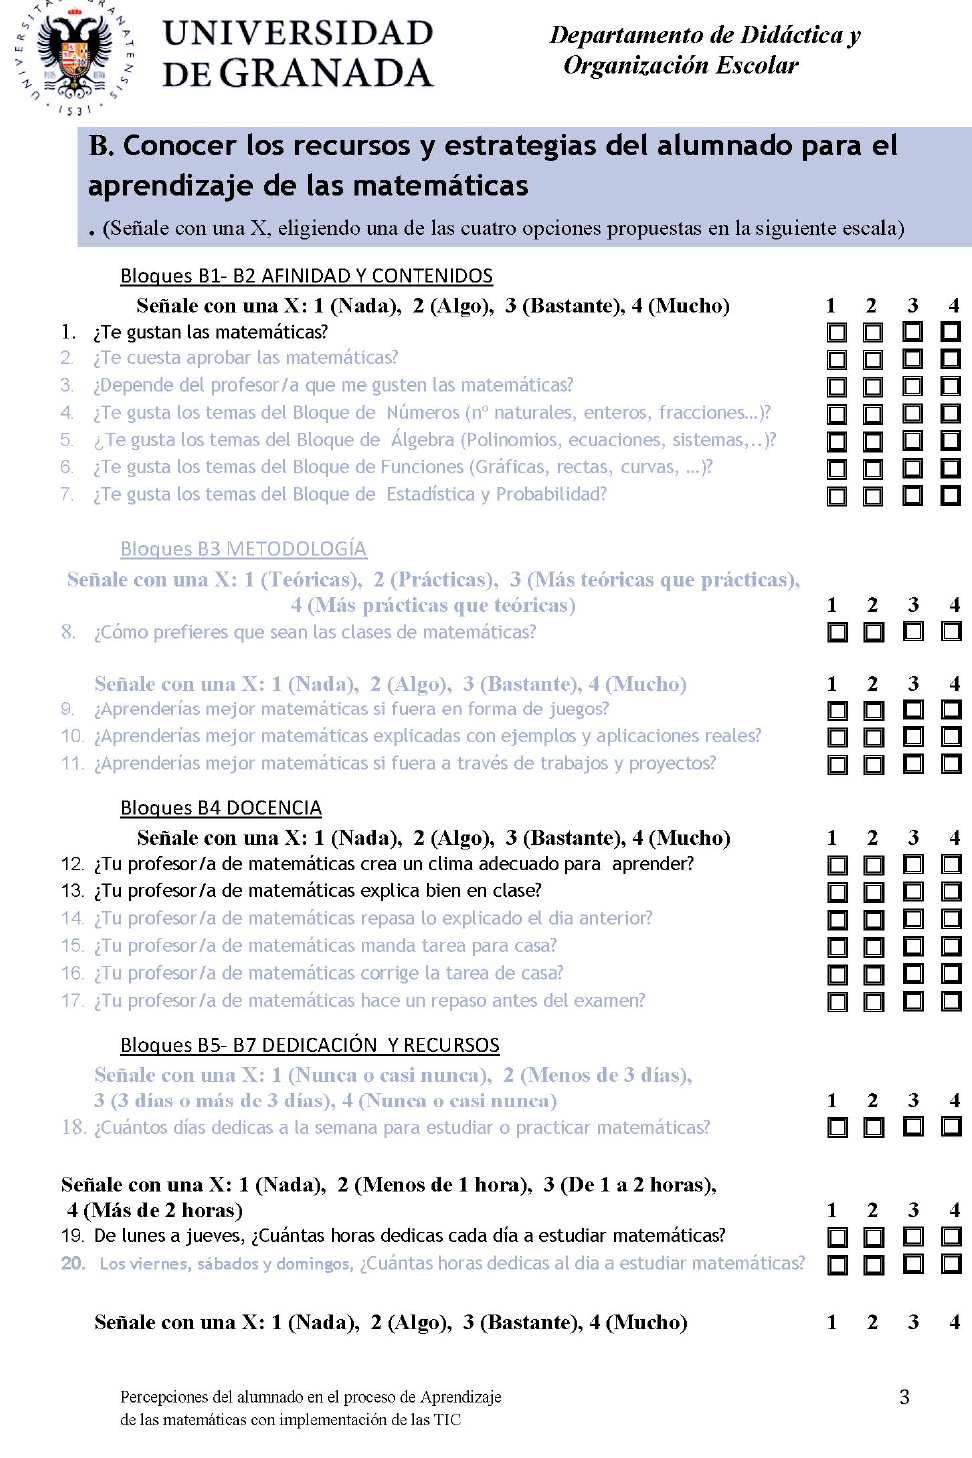
Figure A3. Items of dimension B “Learning Mathematics”.